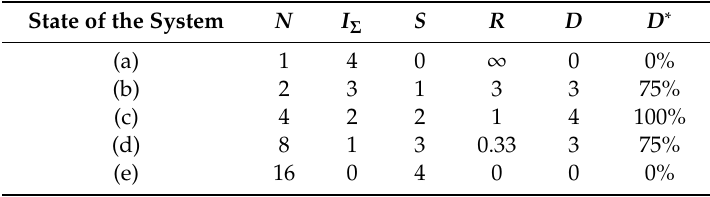
Table 3. Informational characteristics of the system states in Figure